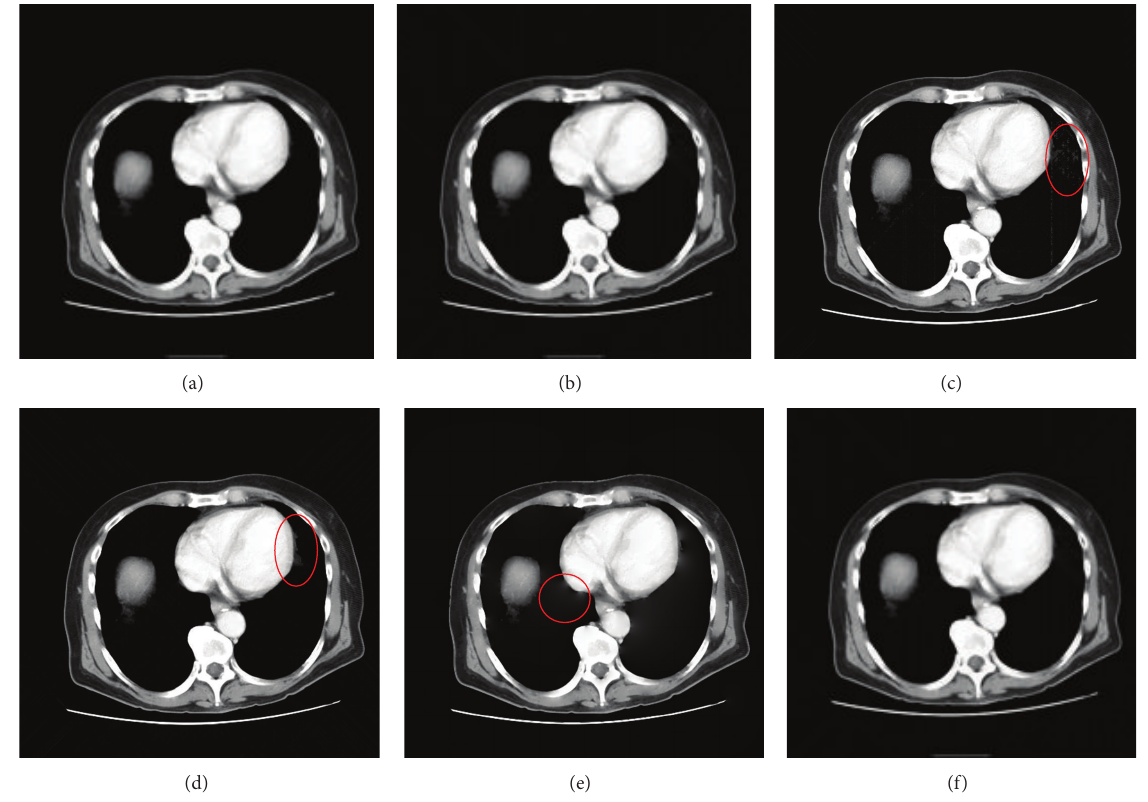
Figure 2: Reconstruction results using different interpolation methods. (a) Original CT kidney image. (b)–(f) Reconstructed results from (b) weighted average, (c) weighted median, (d) central weighted median, (e) PDE, and (f) alpha trimmed weighted